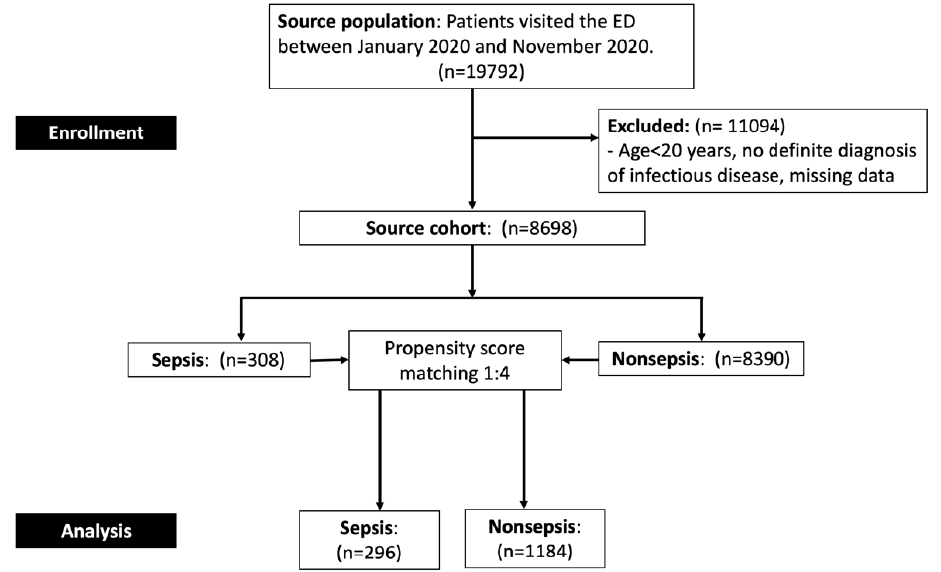
Figure 1. Flow diagram of the study. Table 1. Characteristics of Enrolled Patients.